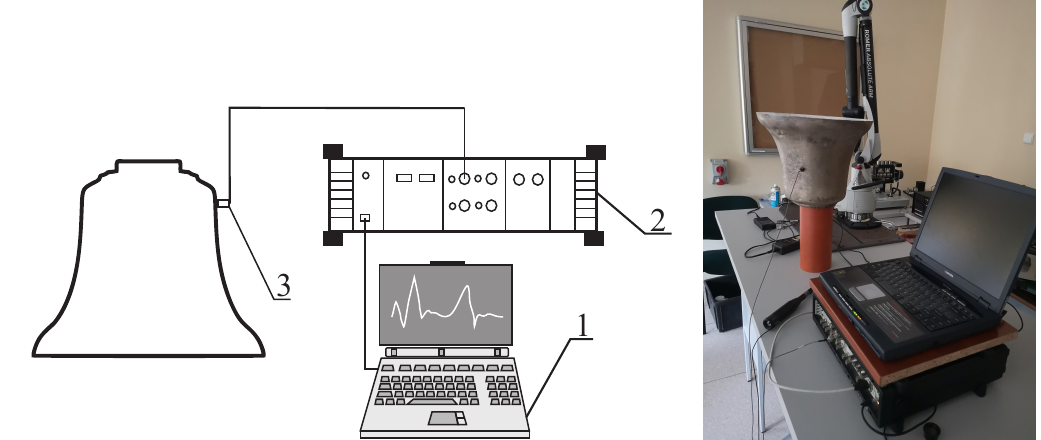
Figure 13. Measuring system for the experimental frequency analysis.